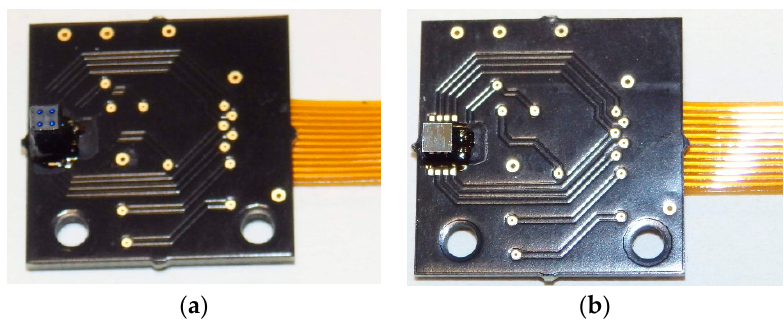
Figure 4. Fluorescence boards: ( a ) excitation and ( b )